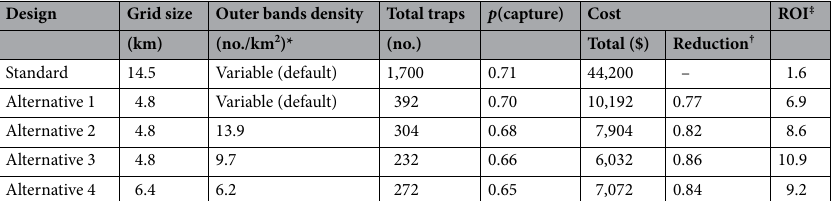
Table 4. Comparison of alternative delimiting survey design options for Medfly , for circular grids with different diameters and trap densities, showing numbers of traps, costs and return on investment (ROI), and the likelihood of capture ( p (capture)). *All alternatives had the same density of 38.9 traps per km 2 in the core. † Reduction relative to the standard survey cost. ‡ ROI: return on investment, capture percentage points for each $1,000